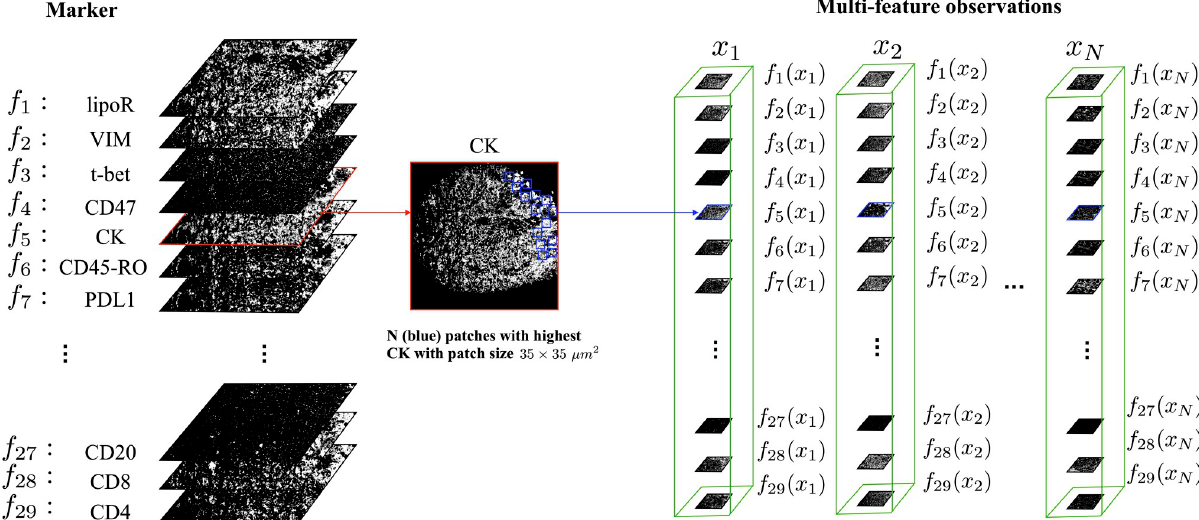
Fig 2. An illustration of the IMC multi-feature observations from a single subject. In the IMC data of a single subject, we focus first on the Cytokeratin marker, which is used as an indicator of tumor cells. We select N ROIs located at the highest Cytokeratin expression levels. These ROIs are patches of size b × b μm 2 , where here b set to 35. We assume that these ROIs have intrinsic hidden states represented by x i . The expression of all 29 markers at these ROIs are viewed as the multi-feature observations f f